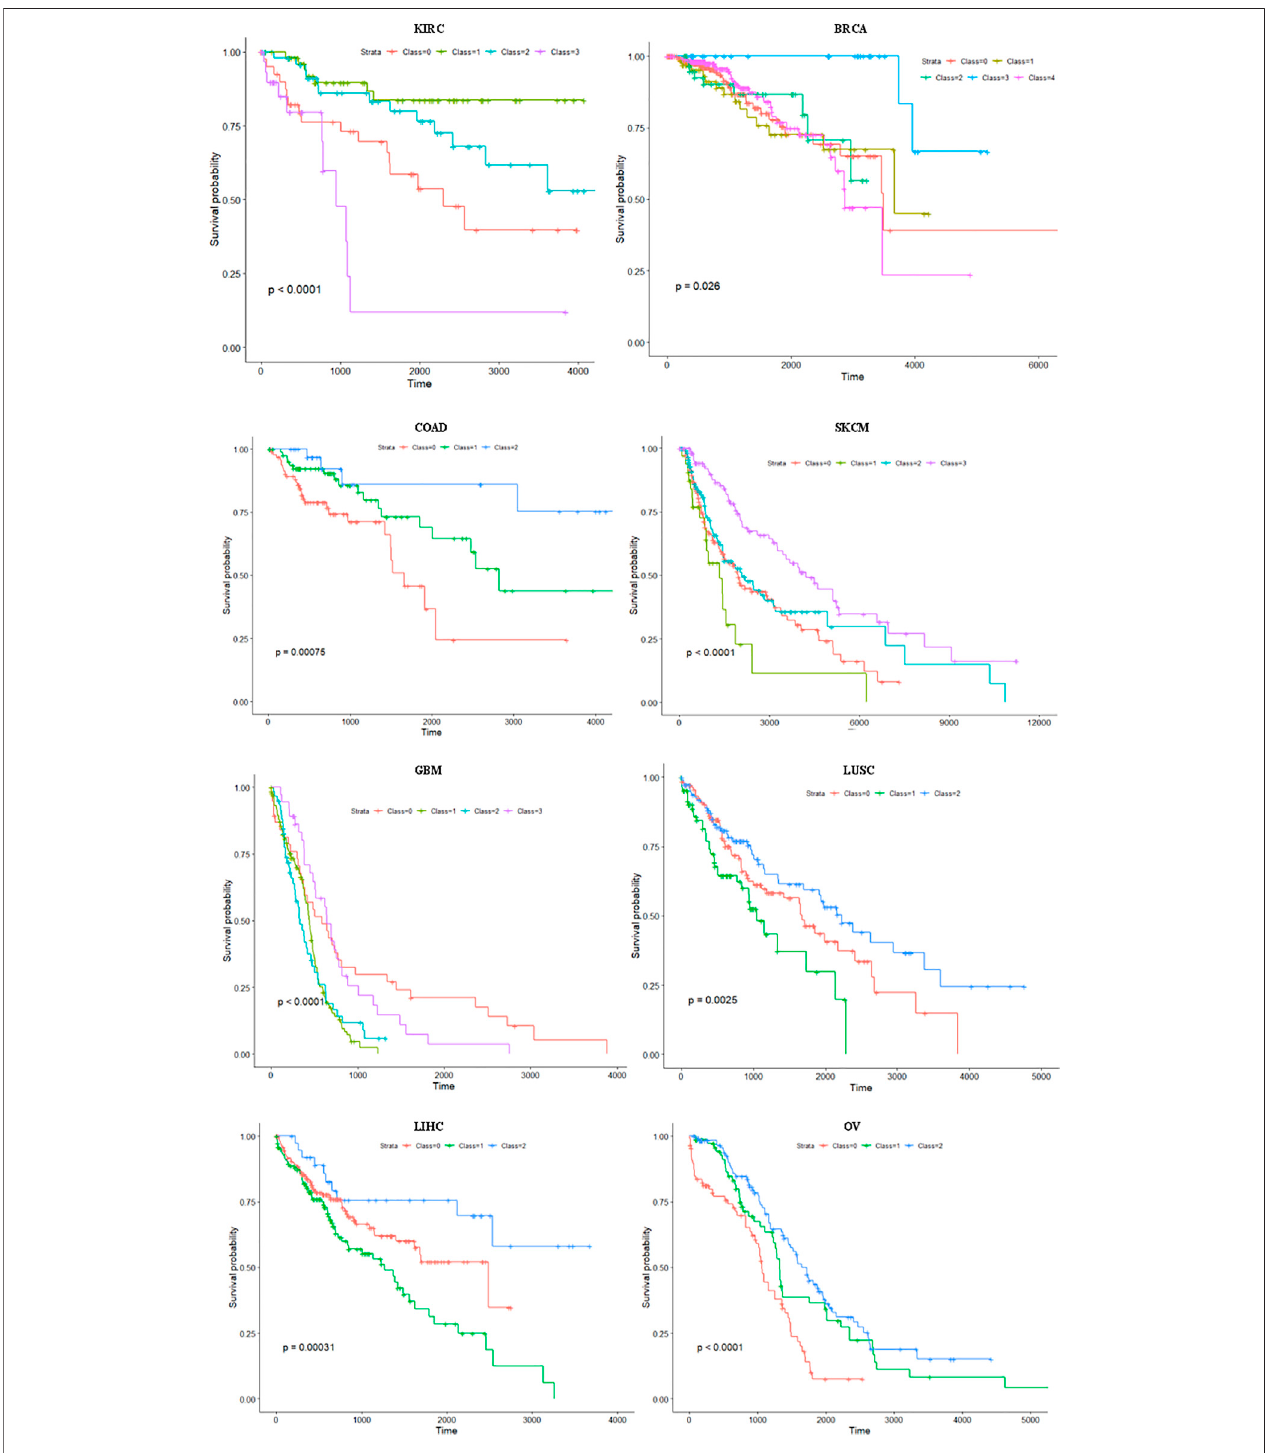
FIGURE 3 | Survival curves for eight cancer